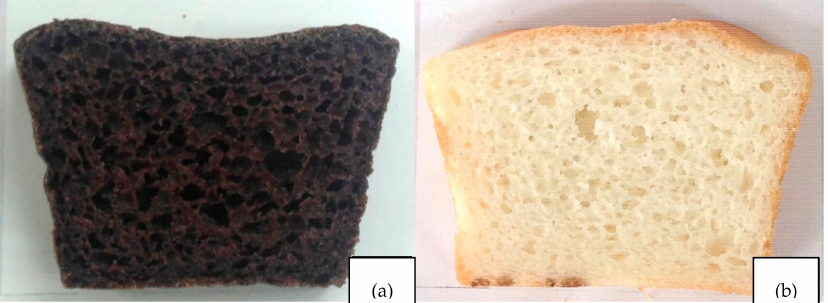
Figure 6. The cross section of gluten free bread from Hom Nil rice flour ( a ) and Hom Mali 105 rice flour ( b